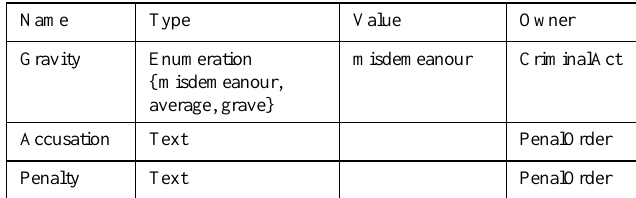
F RAME I NSTANCES FOR P ROPERTY